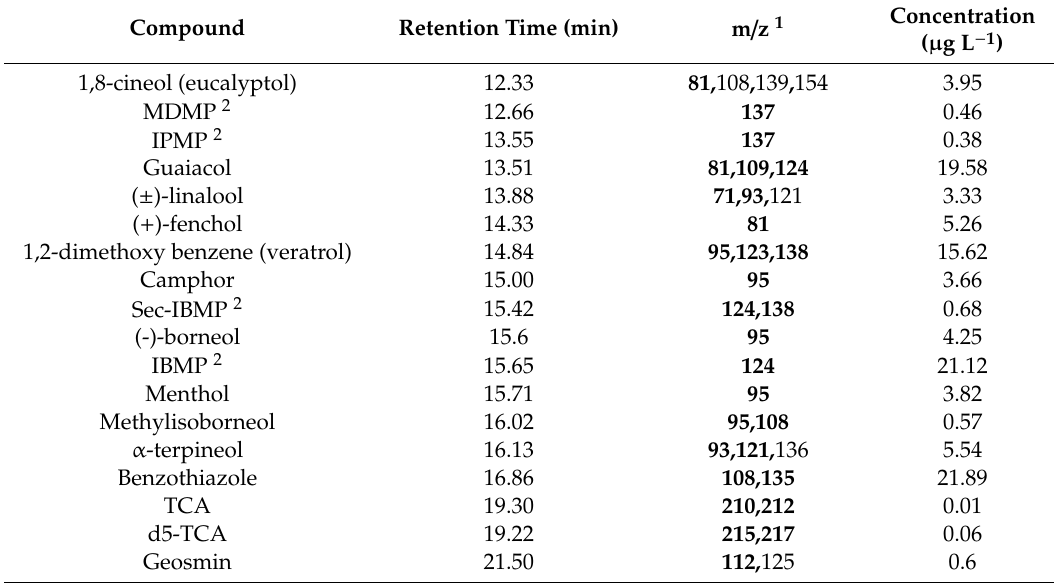
Table 1. Compounds used for target analysis of cork volatiles: retention time, m / z fragments used for the identification and concentration of the compounds in the working solution prepared to confirm the